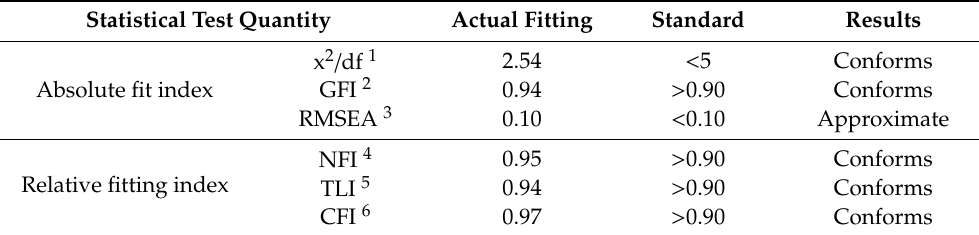
Table 6. Evaluation and fitting results of SEM overall